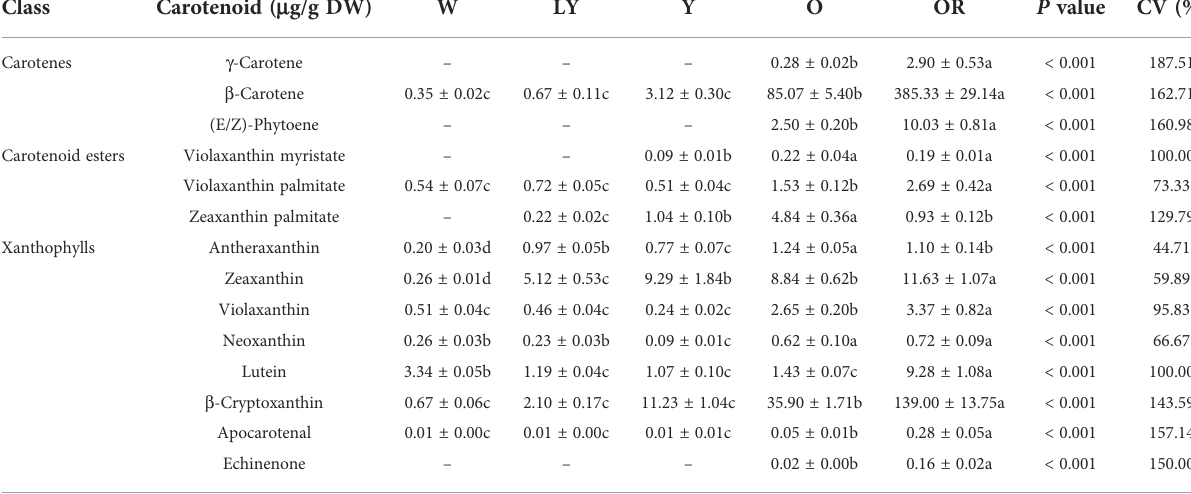
TABLE 1 Content of carotenoids in fi ve sweetpotato